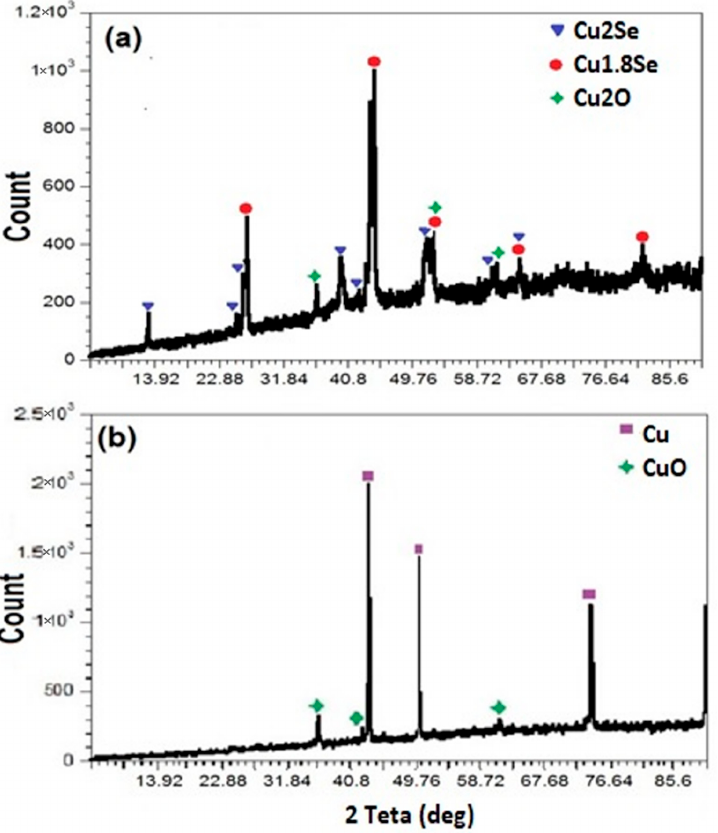
Figure 8. XRD pattern for discrete cementation of ( a ) Se at 4000 mg/L Se, 75 g/L H 2 SO 4 and 15 g/L CuSO 4 and 35 °C and ( b ) Te at 1000 g/L Te, 75 g/L H 2 SO 4 and 15 g/L Cu SO 4 and 35 °C .